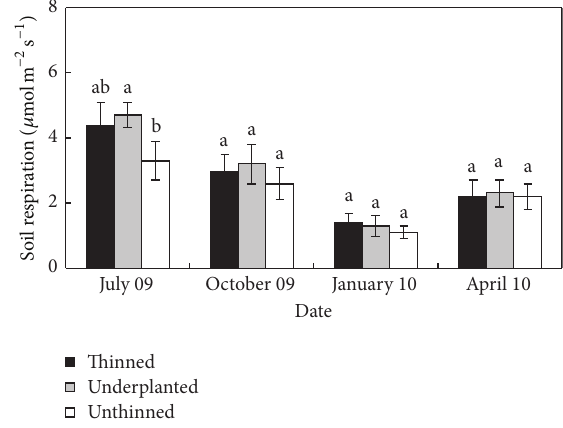
Figure 3: Seasonal change of soil respiration ( 𝜇 molm −2 s −1 ) in the thinned, underplanted, and unthinned treatments; different letters in the same date indicate there are significant differences among the three treatments (5% level, Duncan’s